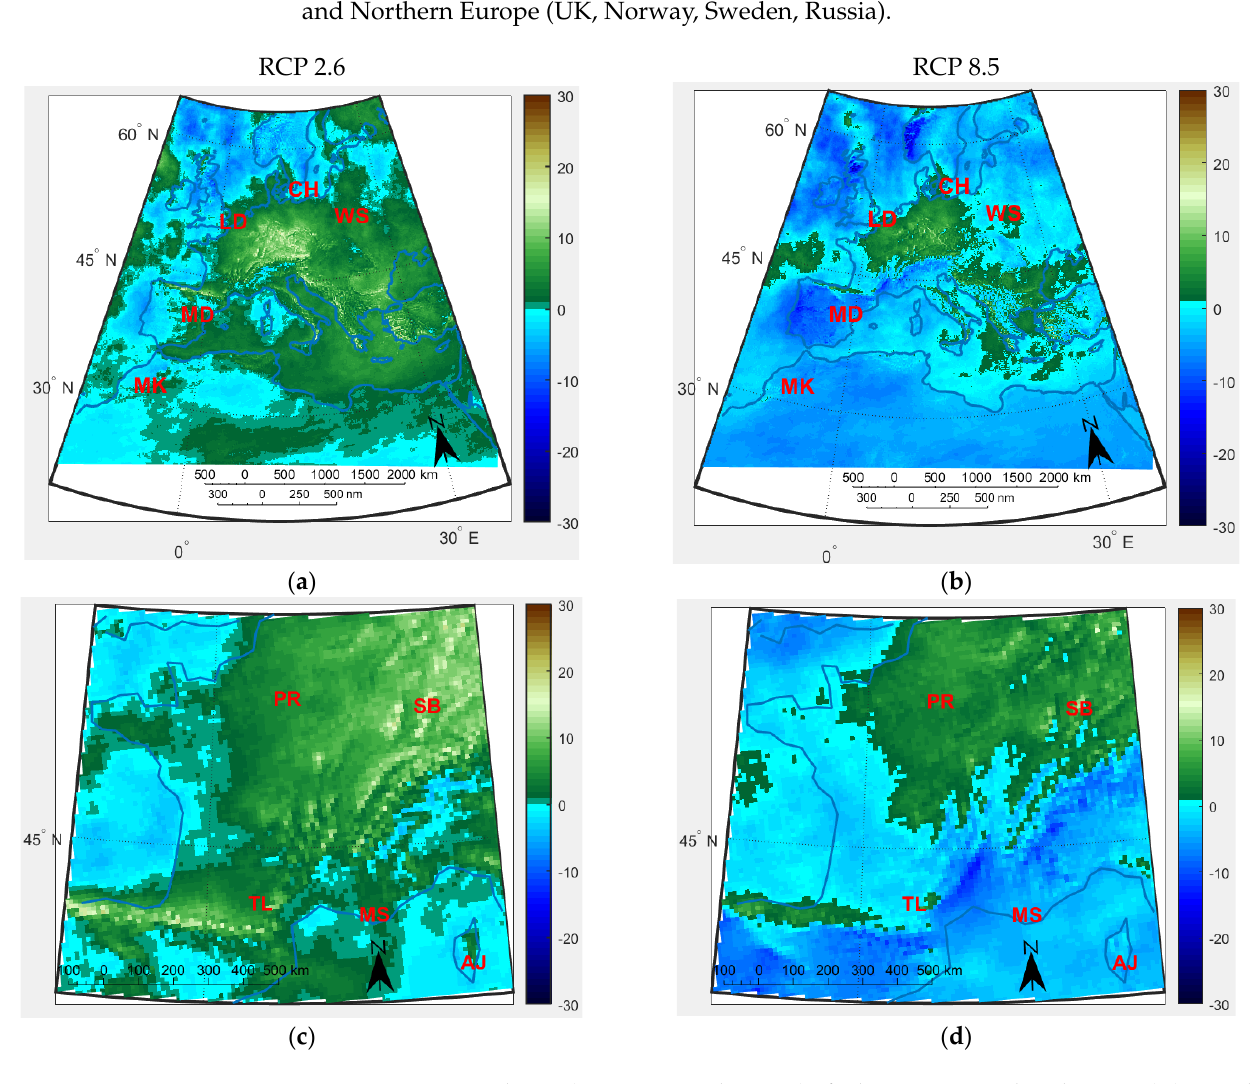
Figure 4. Future evolution (2100 compared to 2005) of relative H 2(g) produced masses (%) according to both emission RCPs scenarios (left: low emission and right: high emission), respectively, for Europe ( a , b ) and France ( c , d ). Red letters: city abbreviations (see Table 1).